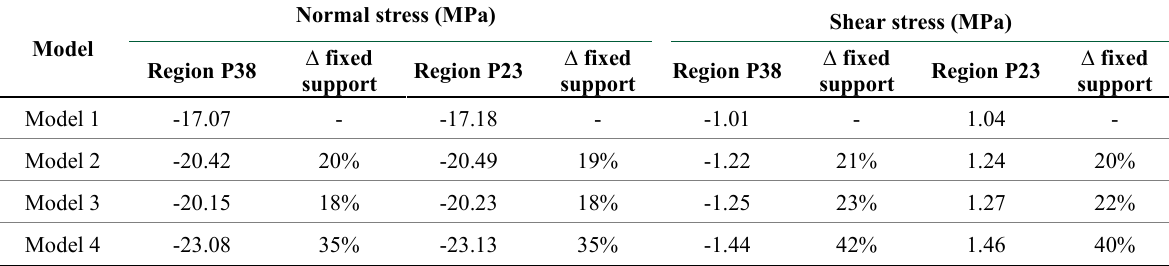
Table 6. Maximum values of normal and shear stresses of wall 41.